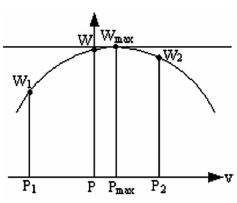
Figure 4. Projection of Figure 1a on the XZ-plane.